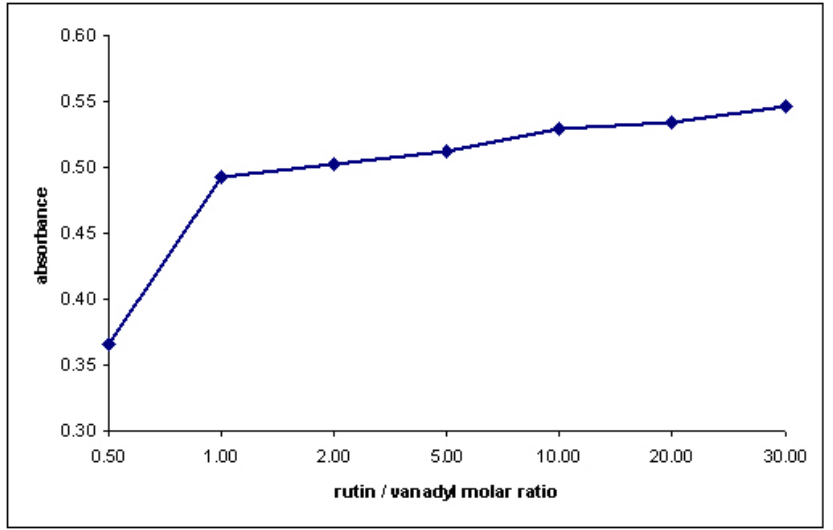
= 0.05 vanadyl sulfate